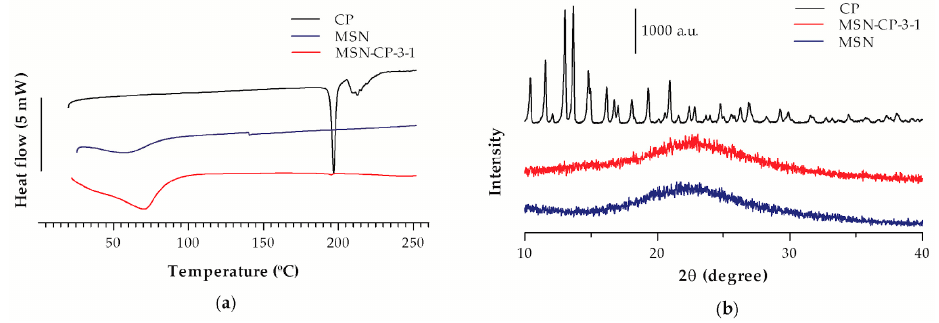
Figure 3. ( a ) Differential scanning calorimetry (DSC) thermal profile and ( b ) X-ray diffraction patterns of crystalline CP (raw material), bare MSN (MCM − 41) and MSN-CP − 3 − 1.